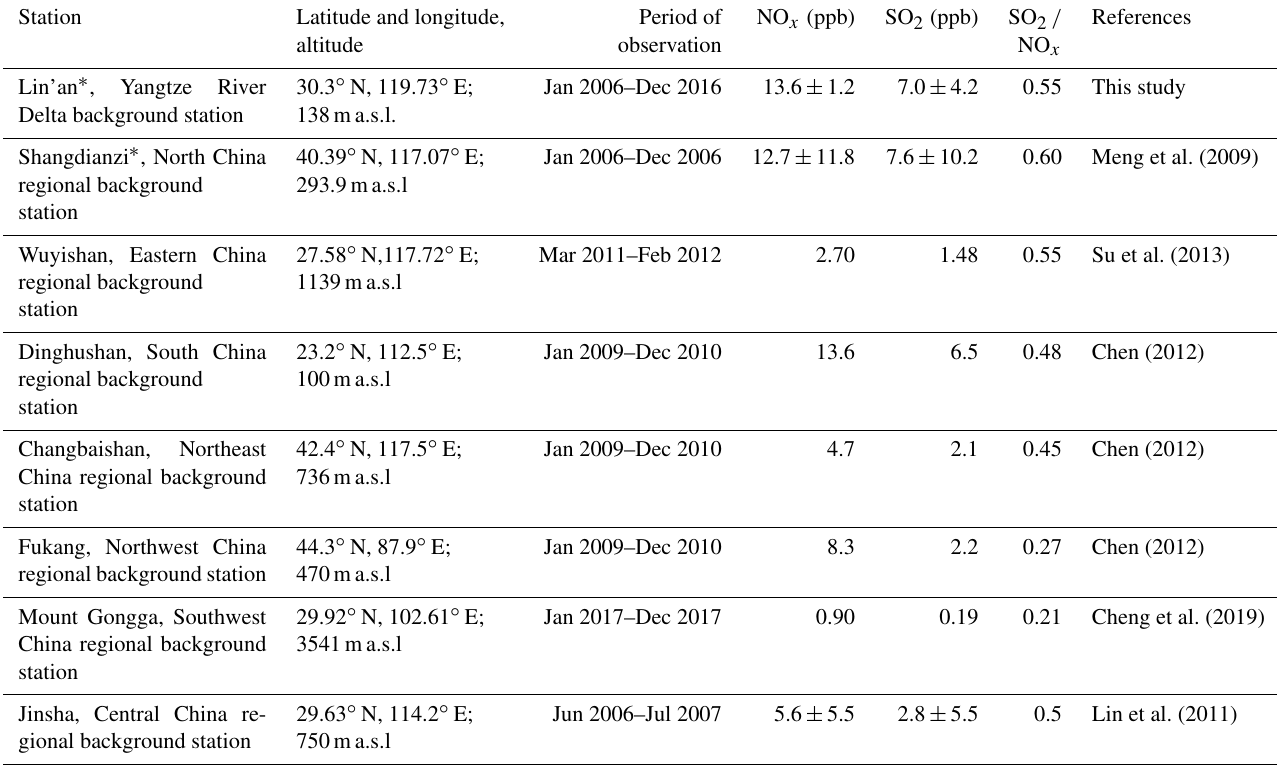
Table 2. NO x and SO 2 mixing ratios observed at various atmospheric background stations. Station Latitude and longitude, Period of NO x (ppb) SO 2 (ppb) SO 2 / altitude observation NO